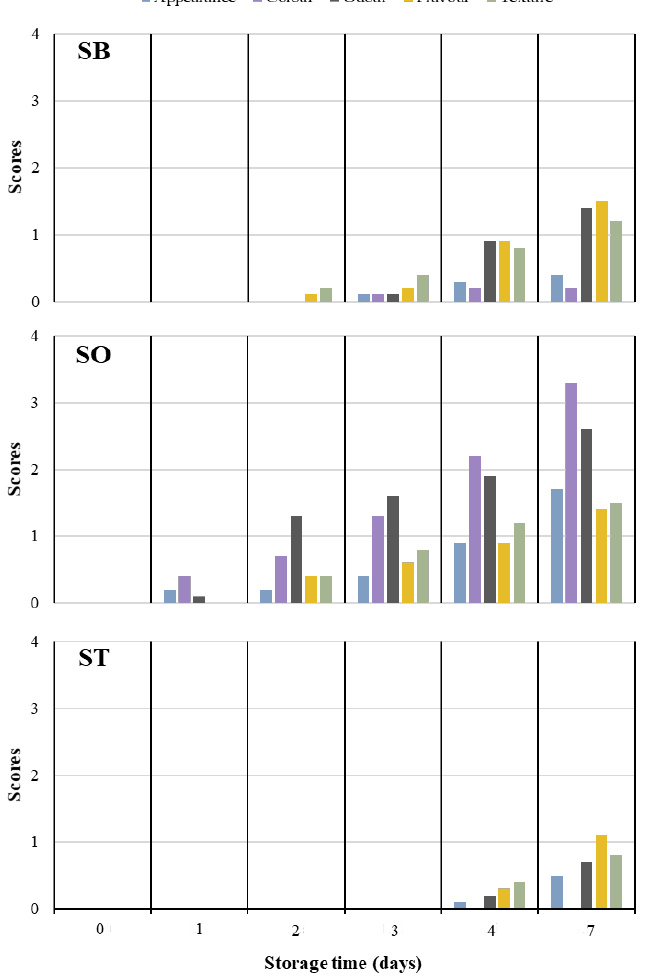
Figure 3. Sensorial analysis of canned sardines in light brine (SB), in vegetable oil (SO) and in tomato sauce (ST) during storage at 4 °C.